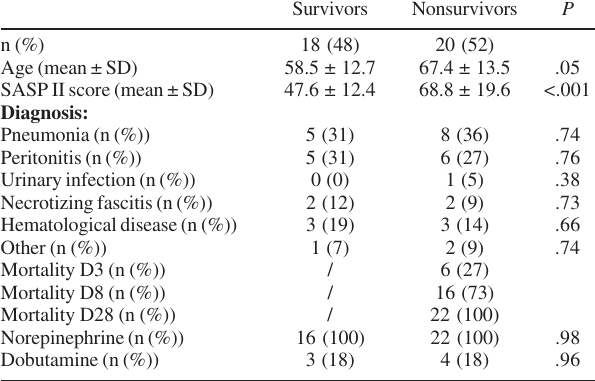
Survivor and nonsurvivor characteristics during the target period (Table 2) Table 2 - Demographic data, diagnosis, mortality rate, and norepinephrine and dobutamine receiving during the first 2 days, comparing survivors and nonsurvivors of the target